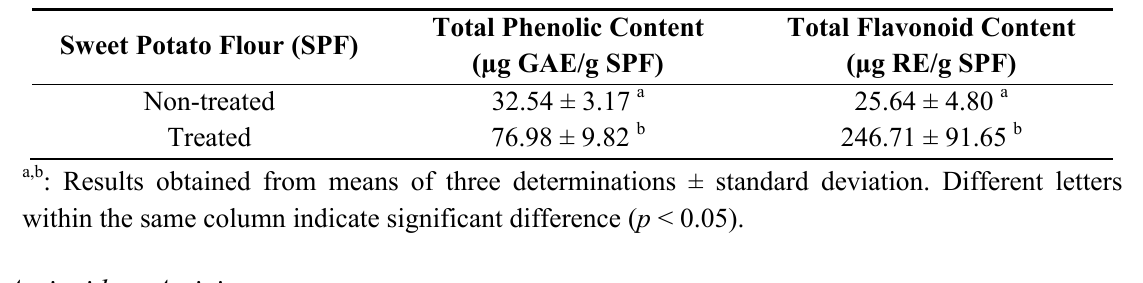
Table 2. Total phenolic and flavonoid contents of SPF as affected by simulated gastrointestinal pH conditions.